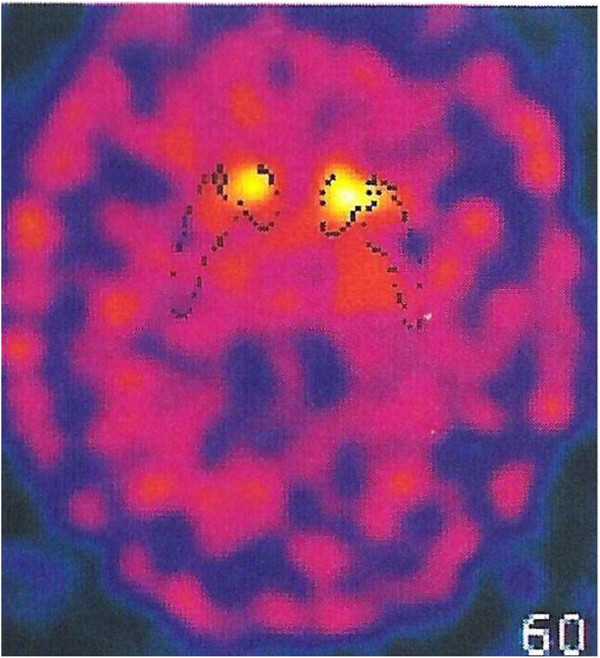
I-FP-CIT SPECT imaging of the dopamine transporter. The imaging of the dopamine transporter revealed reduced binding in both striata, more severe in the right putamen.